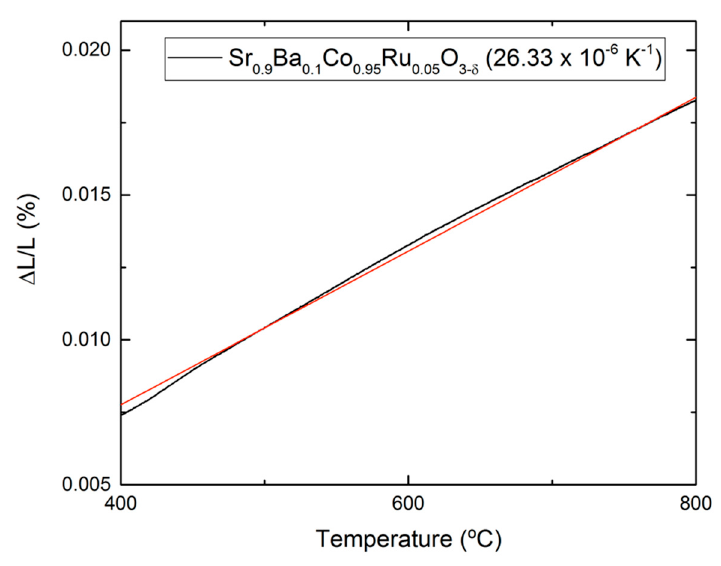
Figure 4. Thermal expansion determined by dilatometry of the perovskite Sr 0.9 Ba 0.1 Co 0.95 Ru 0.05 O 3 − δ collected in two consecutive heating runs.